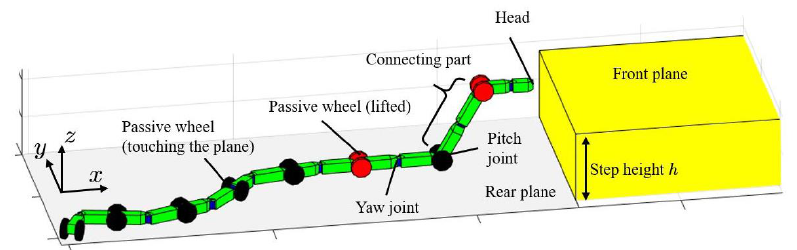
Figure 1. A snake robot and a